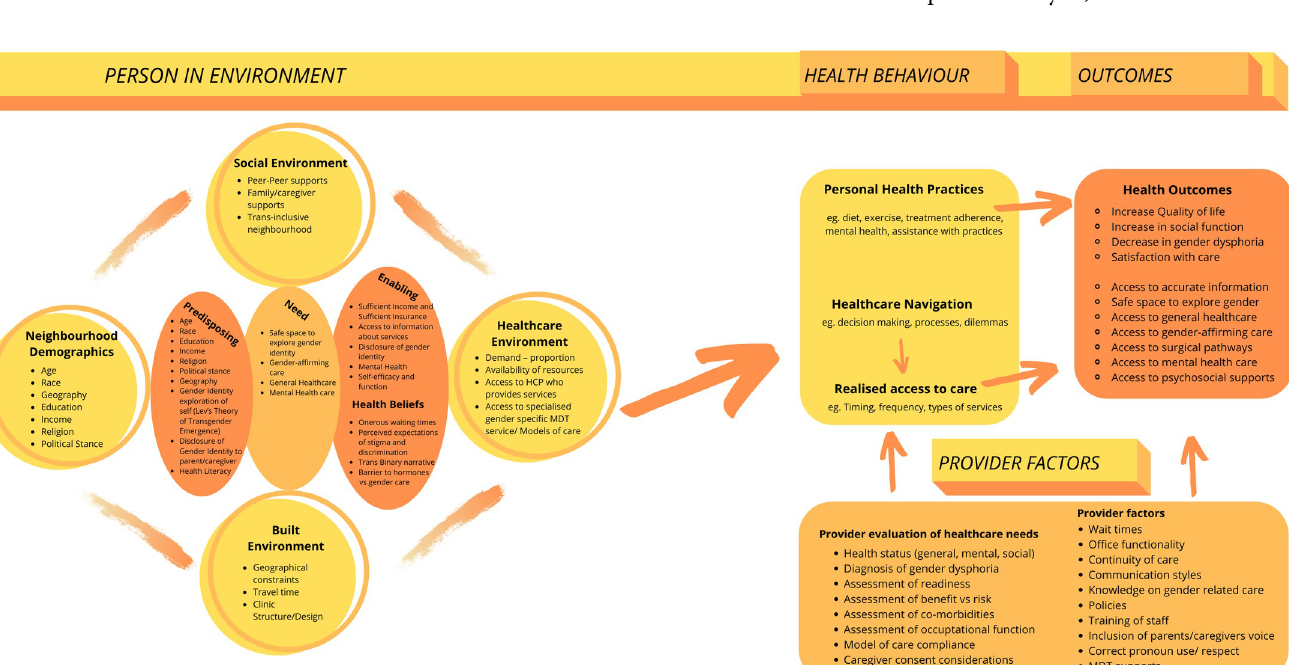
PLOS ONE | https://doi.org/10.1371/journal.pone.0257194 September 10,